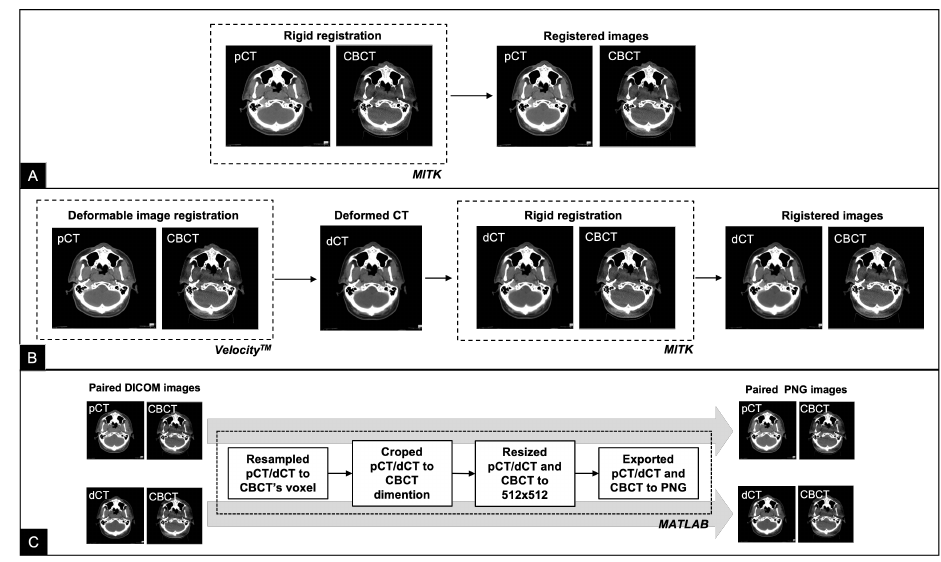
Figure 2. Flowchart of the data preparation process. ( A ) pCT was registered to CBCT using the multi-modal rigid registration algorithm with manual adjustment in MITK workbranch. ( B ) pCT was transformed to align with CBCT using the DIR algorithm in Velocity ™ . The HU values of pCT were then deformed to the CBCT anatomy to create dCT. dCT was then was registered to CBCT in MITK workbranch. ( C ) Both the pCT and dCT volumes were resampled to match the CBCT’s voxel spacing and cropped to match its dimensions using MATLAB.